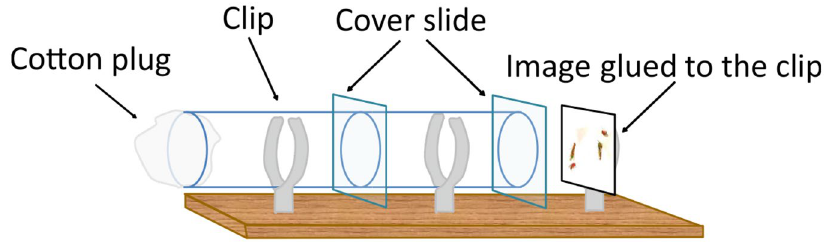
Figure 1. Device used in the mate-copying experiment using images during the demonstration.